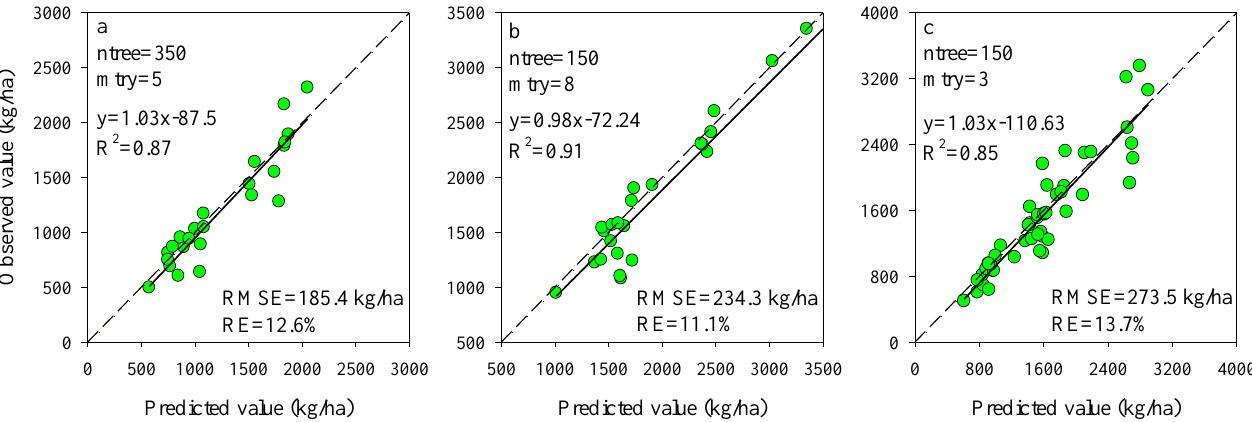
Figure 7. Predictive performance of RF models based on the best modeling in Figure 4 at ( a ) tuber formation, ( b ) tuber bulking, and ( c ) the combined growth stage using testing dataset.